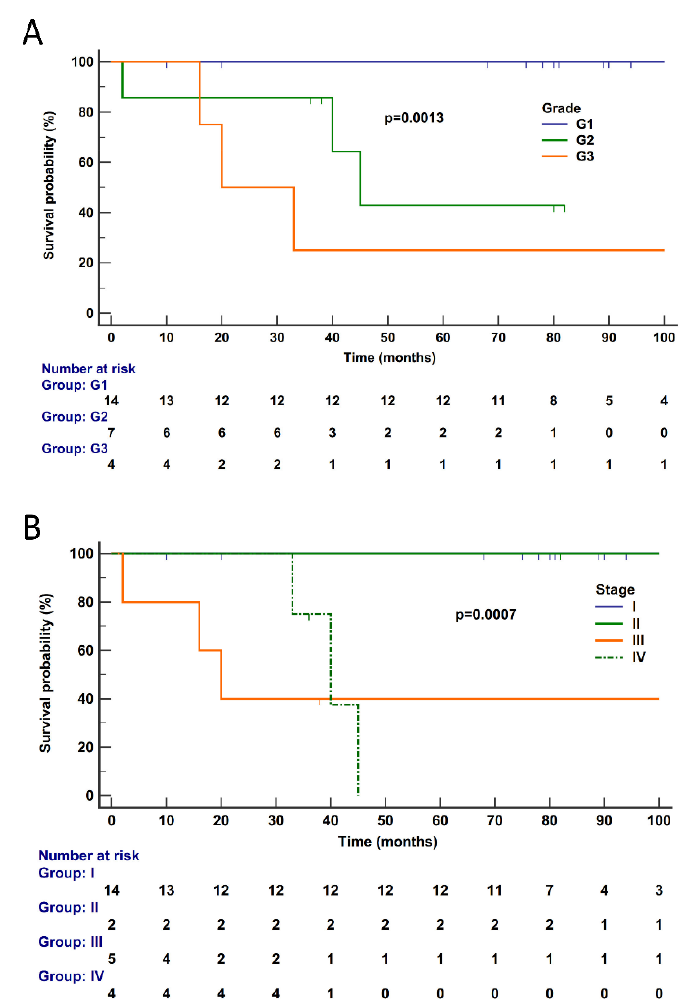
Figure 4. Disease-specific survival according to pathological features in 25 PanNETs. Disease-specific survival of patients is significantly affected by tumor grade ( A ) ( p = 0.0013) and stage ( B ) ( p = 0.0007). Follow-up time is expressed in months. Kaplan–Meier and log-rank statistics were used to determine levels of significance. Follow-up time was curtailed at 100 months when the total number of patients at risk was 5 (20%) and thus no longer informative.